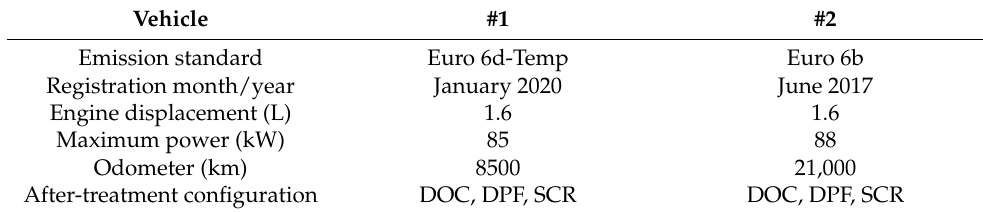
Table 1. Characteristics of the two vehicles tested.